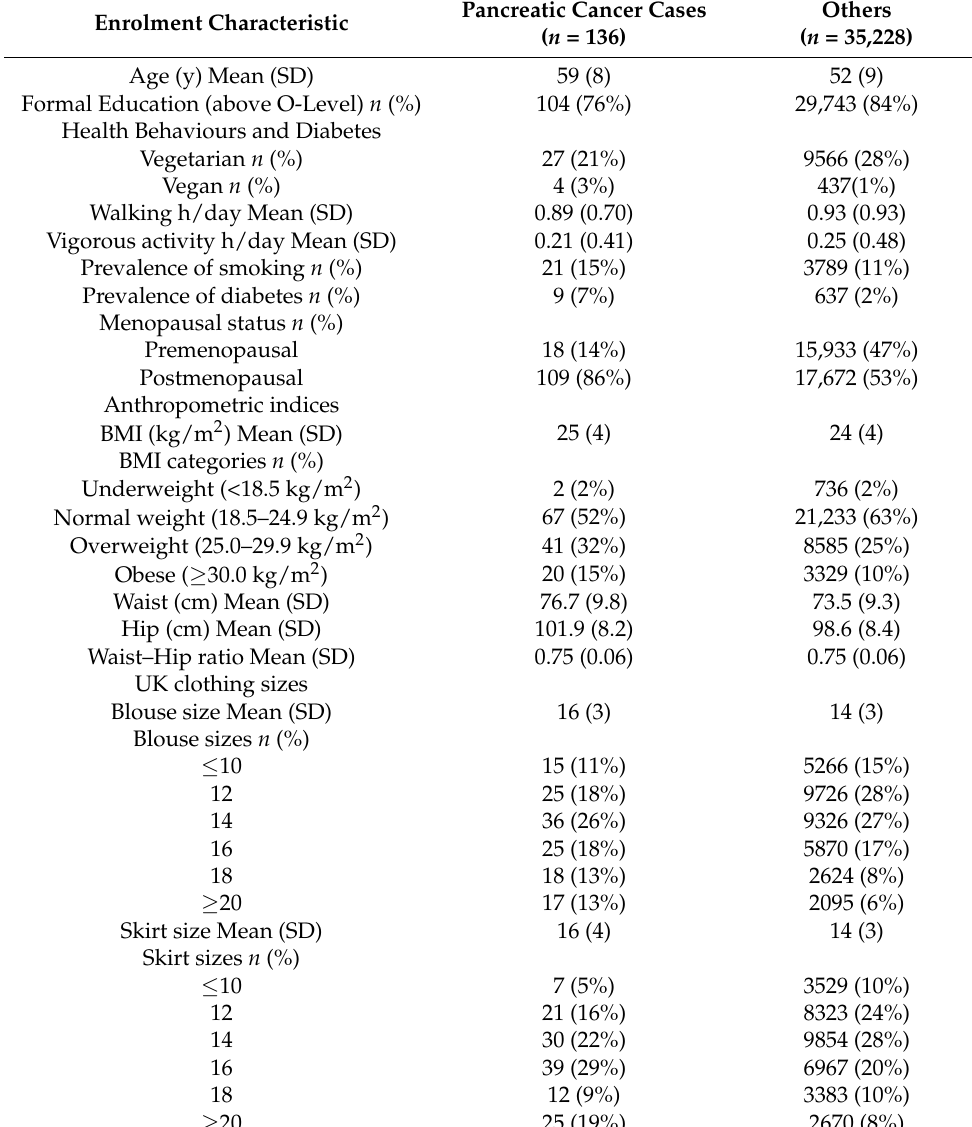
Table 1. Descriptive characteristics at enrolment in the UK women’s cohort study (UKWCS) by pancreatic cancer